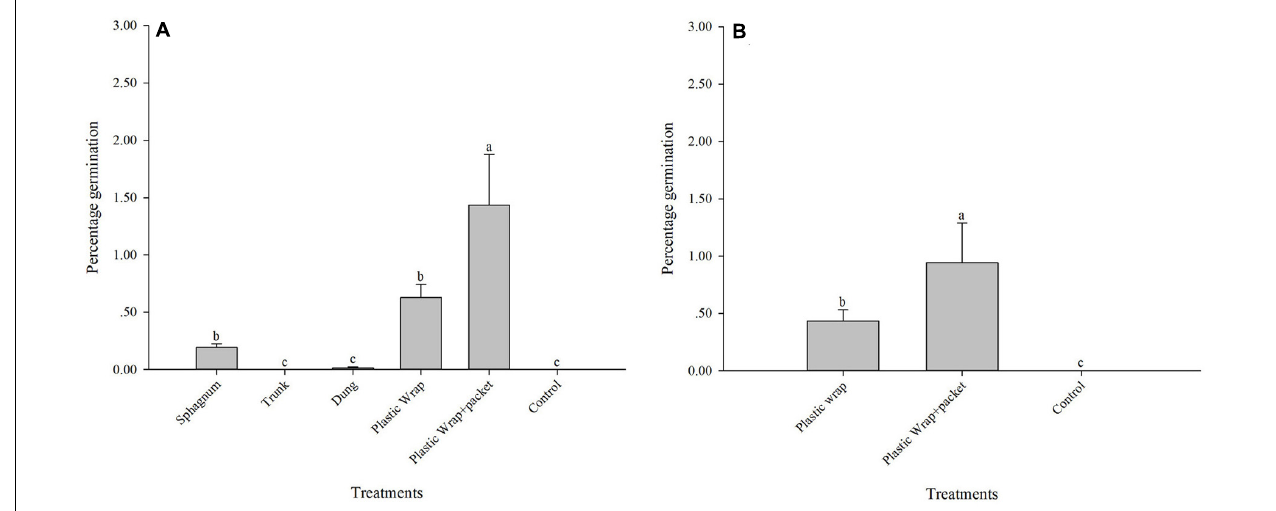
FIGURE 1 | In situ symbiotic seed germination for Dendrobium devonianum at two study locations, Longpa and Yiwu, Yunnan, China. Letters above bars indicate significant differences in mean percentage germination. (A) In situ seed germination for the six treatments evaluated at the Longpa site. (B) In situ seed germination for the three treatments tested at the Yiwu site. TABLE 1 | Pairwise comparison of the effect of six treatments on seed germination in Dendrobium devonianum at the Longpa site and three treatments at the Yiwu site, both in Yunnan Province, China. Location Treatment Sphagnum Trunk Dung Plastic Wrap Plastic Wrap and packet